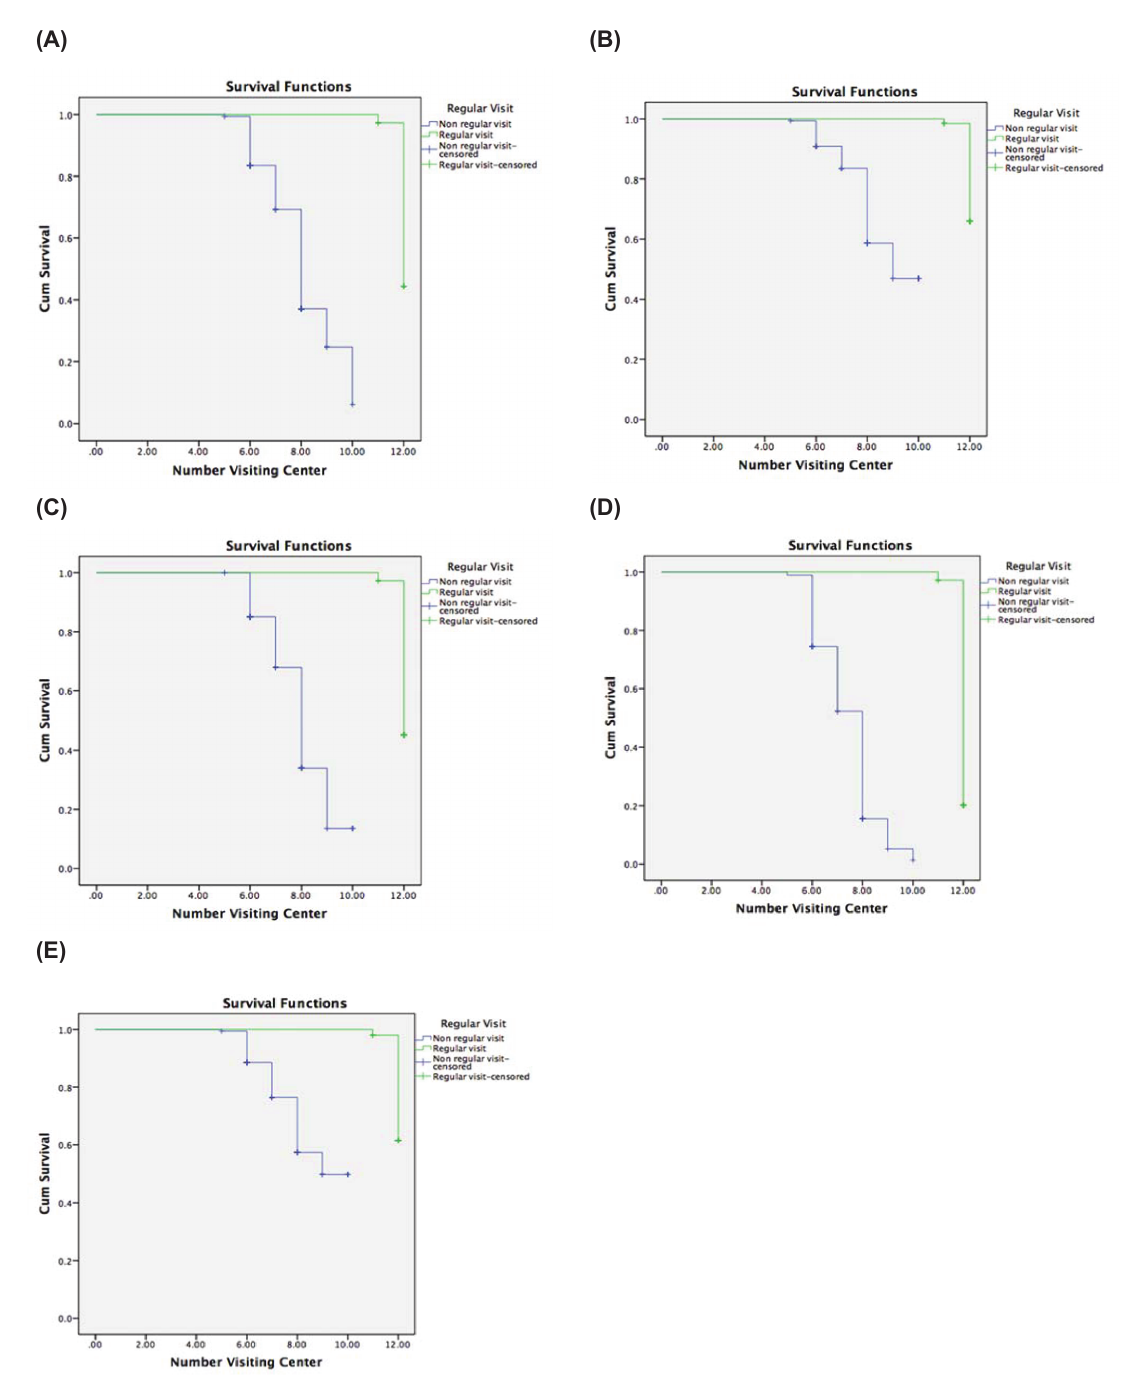
Figure 2. (A) Survival for Overweight. (B) Survival for Abdominal Overweight. (C) Survival for Hypertension. (D) Survival for Diabetes Mellitus. (E) Survival